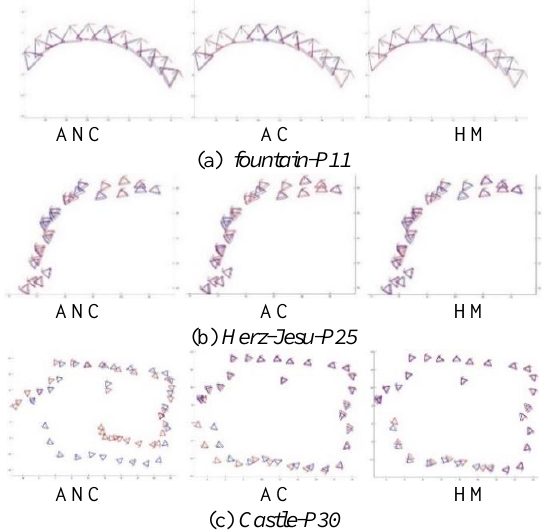
Figure 6. Motion trajectory of three benchmarks with different pipelines, red triangles denote the results computed from corresponding pipelines and blue triangles indicate the ground truth exterior parameters.